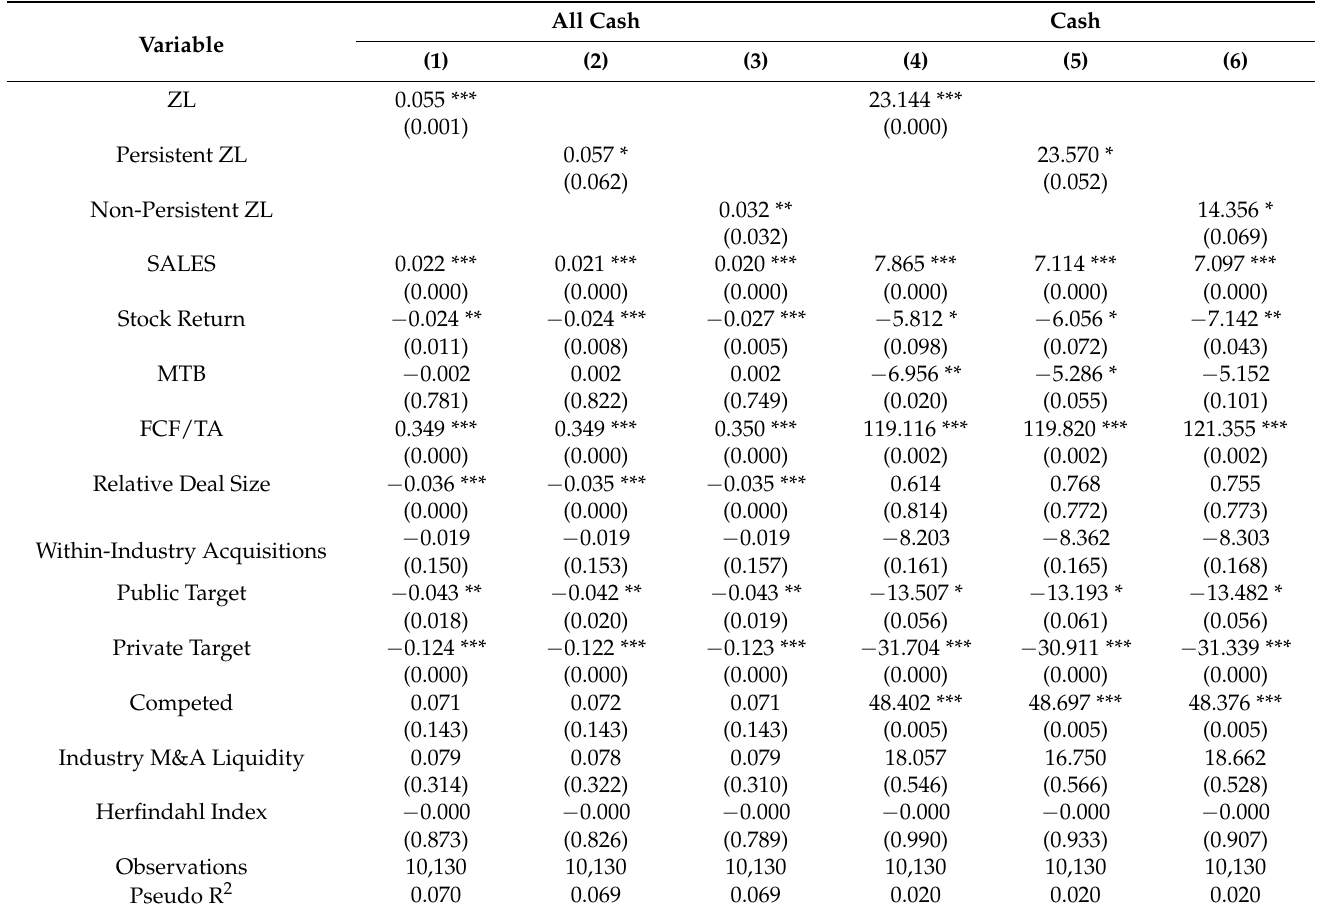
Table 6. The effect of leverage deviation on the method of payment. This table reports the results of probit (Columns (1)–(4)) and tobit (Columns (5)–(8)) regressions investigating the effect of zero- leveraged, under-leveraged, over-leveraged, and leverage deviation on the likelihood of making an all-cash offer and cash proportion of deal, respectively. The dependent variable in Columns (1)–(4) ((5)–(8)) is the indicator variable for making an all-cash offer (the percentage of cash offered). The dependent variable in tobit model in Columns (5)–(8) is censored at 0 and 100. All variables are defined in Appendix A. The average marginal effects of probit (Columns (1)–(4)) and tobit (Columns (5)–(8)) regressions are reported. Each regression includes year dummies. The p -values reported in parenthesis are based on standard errors clustered by 3-digit SIC industry. The symbols ***, **, and * denote statistical significance at the 1%, 5%, and 10%,